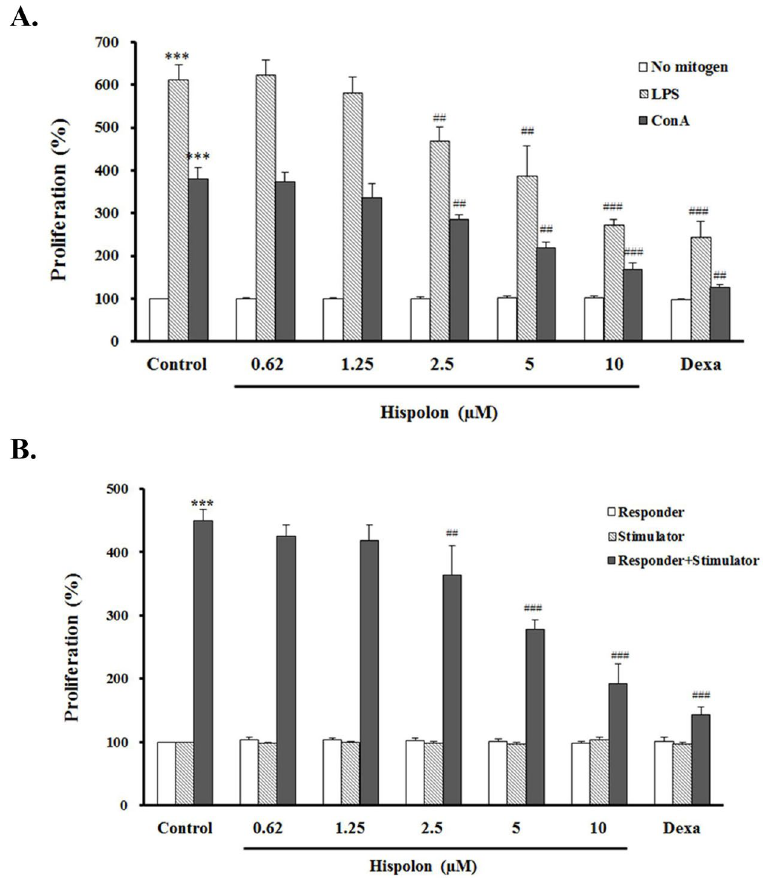
Figure 6. Effect of hispolon on mitogen or alloantigen-treated mouse splenocytes. ( A ) Primary splenic cells isolated from BALB/c mice were treated with 0.62, 1.25, 2.5, 5, or 10 μM hispolon and cultured in a flat-bottomed 96-well plate in the presence of ConA or LPS. ( B ) The splenocytes from BALB/c and DBA mice were used as responder cells and stimulator cells, respectively, and the cells were cultured at a ratio of 1:2 (responder: stimulator) in U-bottomed 96-well microplates. The mixed lymphocytes were treated with 0, 0.62, 1.25, 2.5, 5, or 10 μM hispolon, and then proliferation was measured. After the incubation, a change in proliferation was observed. Dexamethasone (Dexa) served as a positive control. Each value represents the mean ± SD of three separate measurements performed in triplicate ( n = 3). Significance was analyzed using one-way ANOVA; *** p < 0.001, vs. control group; ## p < 0.01 and ### p < 0.001, vs. LPS- or ConA-treated group, responder + stimulator group.